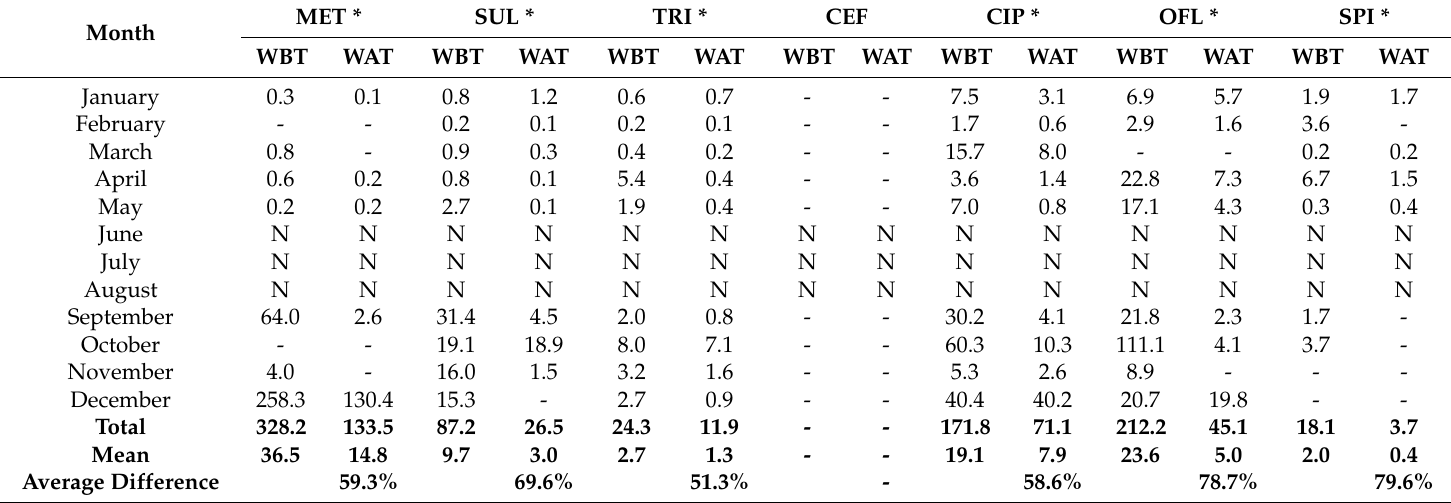
Table 3. Concentrations ( µ g/L) of studied antibiotics in wastewater of an urban hospital in